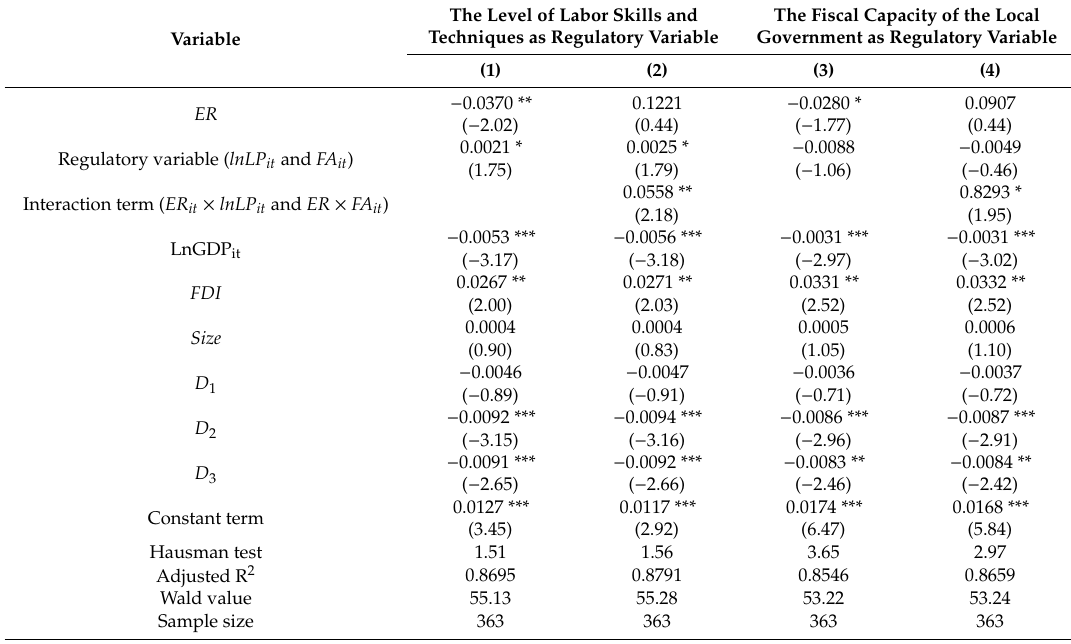
Table 3. The test result of the regulatory e ff ect between environmental regulations and scientific and technological competitiveness in resource-based